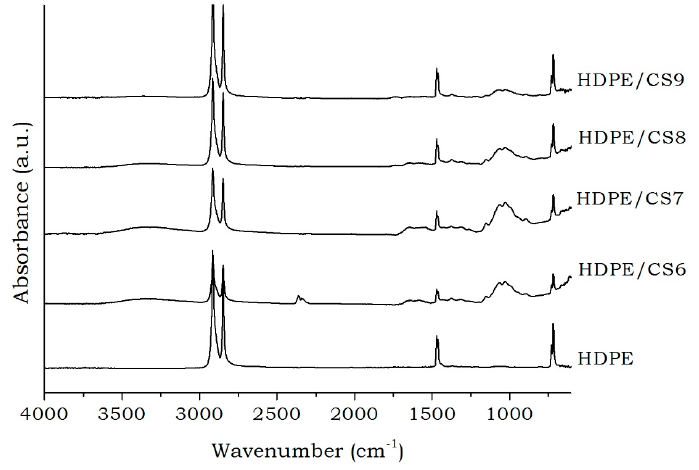
Figure 2. FTIR spectra of High density polyethylene (HDPE) and HDPE/chitosan (CS) formulations.